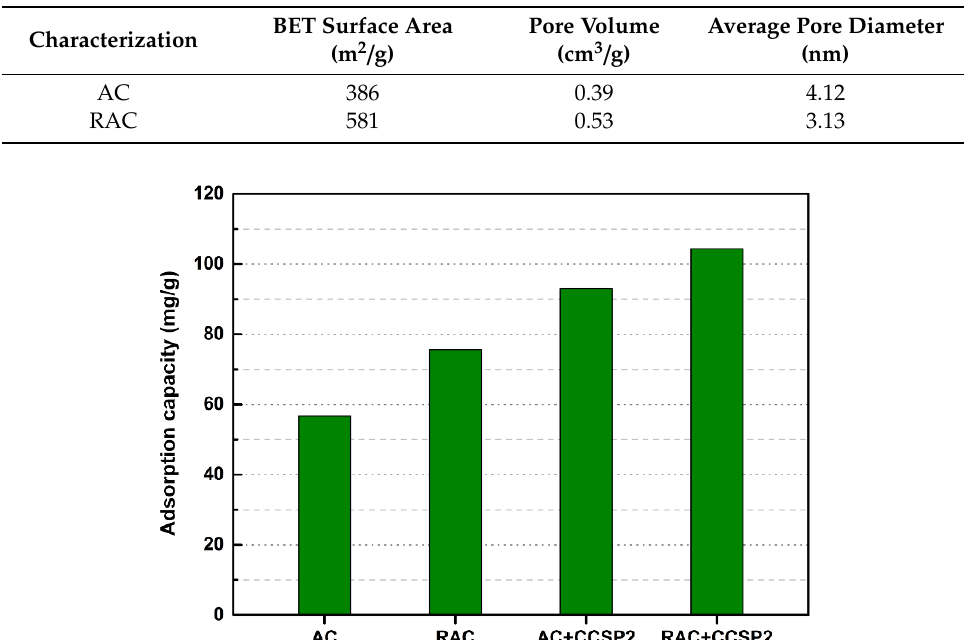
Figure 9. The adsorption capacities of the AC and RAC to the simulated textile wastewater in column.